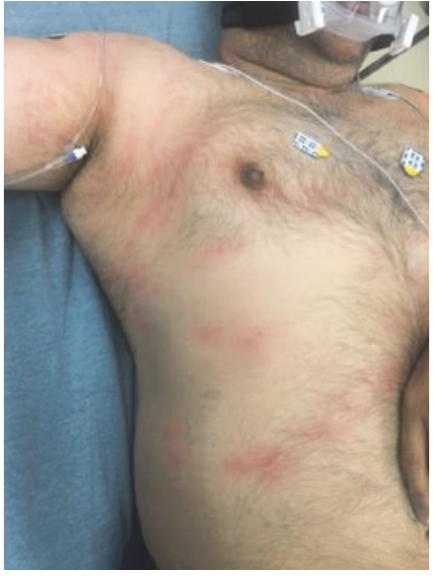
Figure 1: Cutis marmorata: skin mottling over chest and